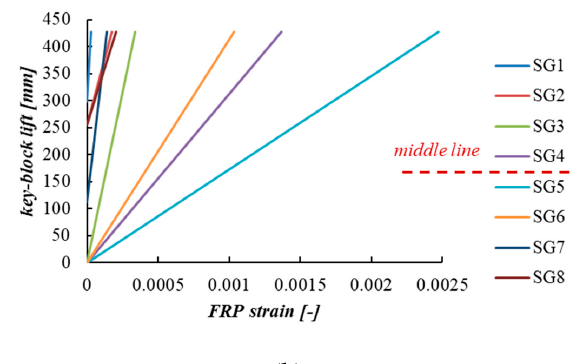
Figure 13. Data elaboration: ( a ) symmetry level of the lifting and ( b ) FRP ‐ strains with respect to the lift of the key ‐ block.